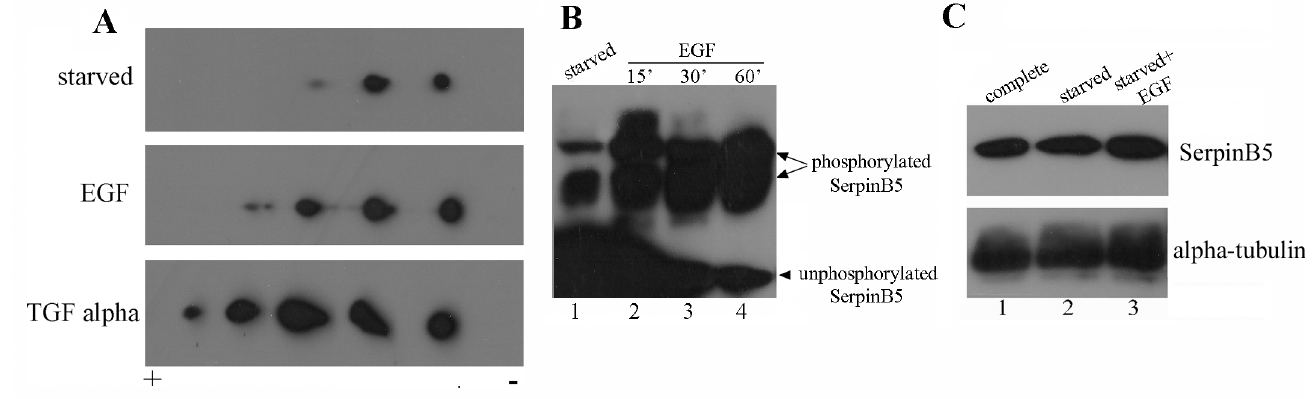
Fig 3. EGF and TGF alpha regulate SerpinB5 phosphorylation in MCF-10A cells. A . Starved MCF-10A cells were left untreated (upper panel) or treated with 20 ng/ml with EGF (middle panel) or TGF alpha (lower panel) for 20 minutes. 1.7 mg of protein extracts were analyzed by 2D-SDS-PAGE using 17 cm pH 4.7 – 5.9 IPG strips followed by Western blot with anti-SerpinB5 (BD Pharmigen); B. Starved MCF-10A cells were left untreated (lane 1) or treated with 20 ng/ml of EGF for the indicated periods of time (lanes 2 – 4). 50 ug of whole protein extracts were resolved by 8% Phos-Tag ™ SDS-PAGE gel to separate the phosphorylated species. Proteins were transferred to PVDF membrane and probed with rabbit anti-SerpinB5 (Santa Cruz); C. MCF-10A cells were grown in complete medium (lane 1) or starved medium without (lane 2) or with 20 ng/ml of EGF for 15 min (lane 3). 50 ug of whole protein extracts were resolved by 12% SDS-PAGE, transferred to PVDF membrane and probed with anti-SerpinB5 (Millipore) or anti-alpha- tubulin for a loading control. This result is representative of two independent experiments.